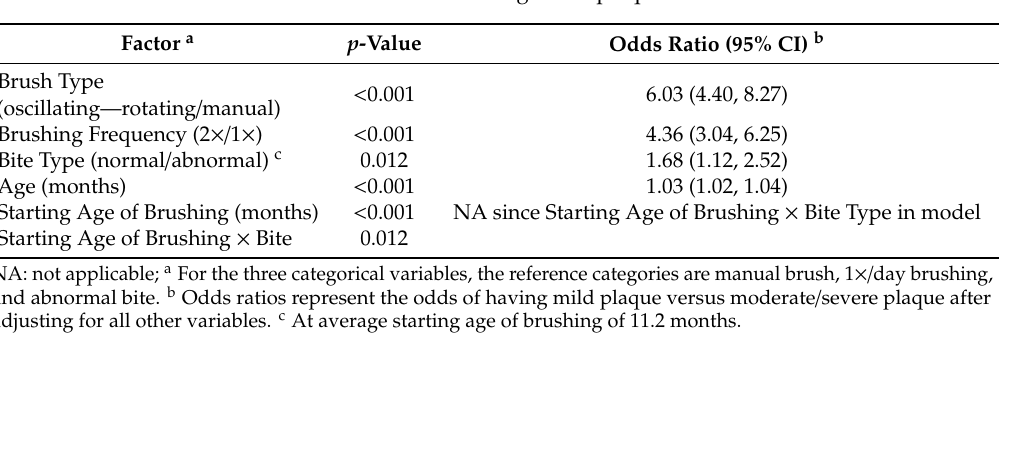
Table 2. Factors contributing to the plaque